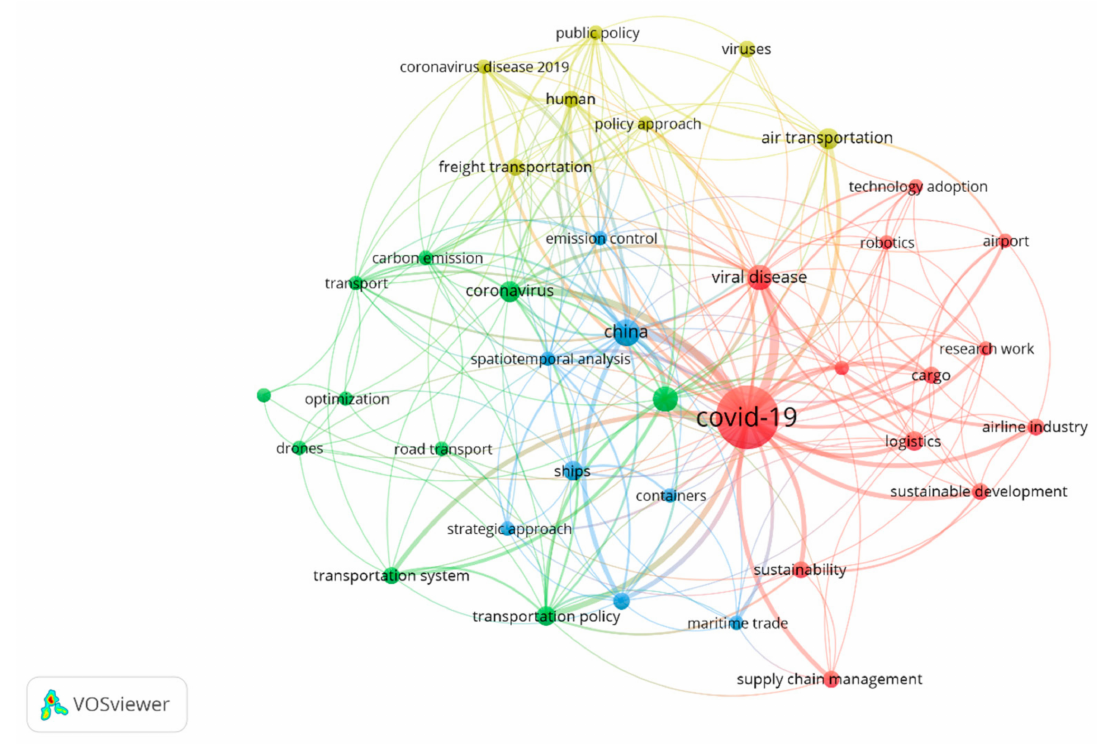
Figure 4. Keyword mapping